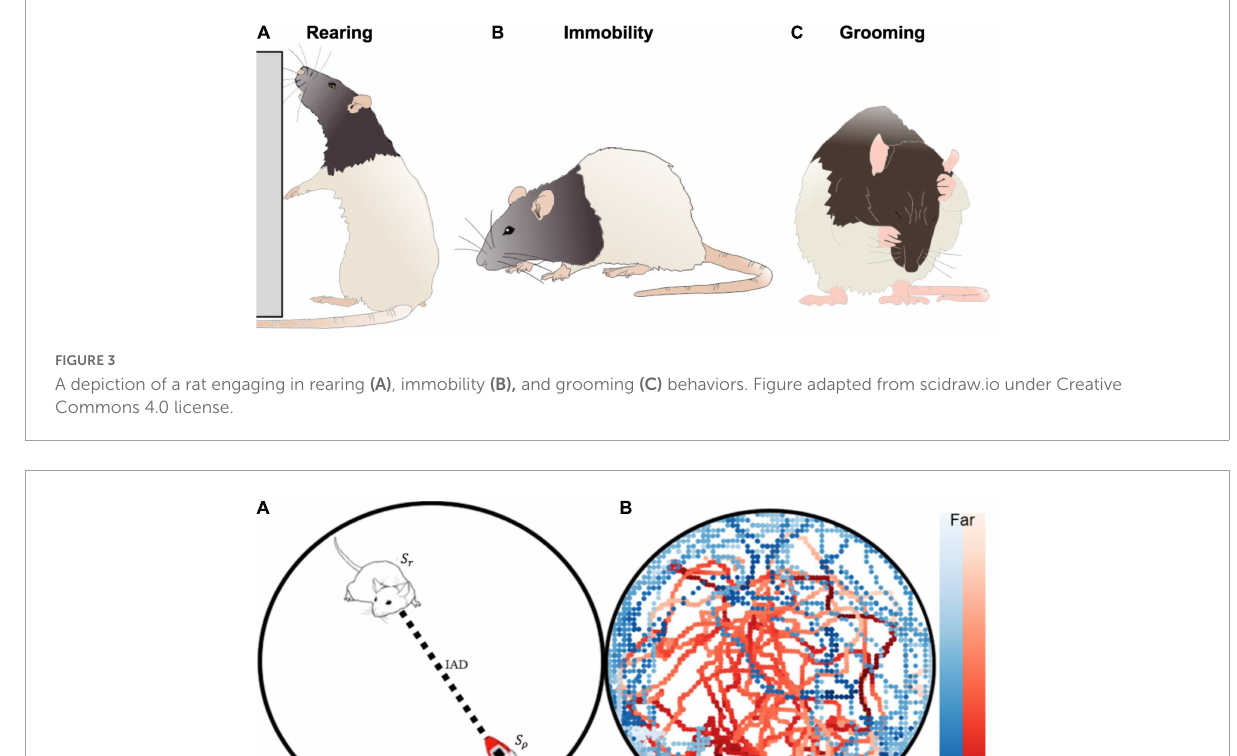
Robots were distinguished visually by color (red and